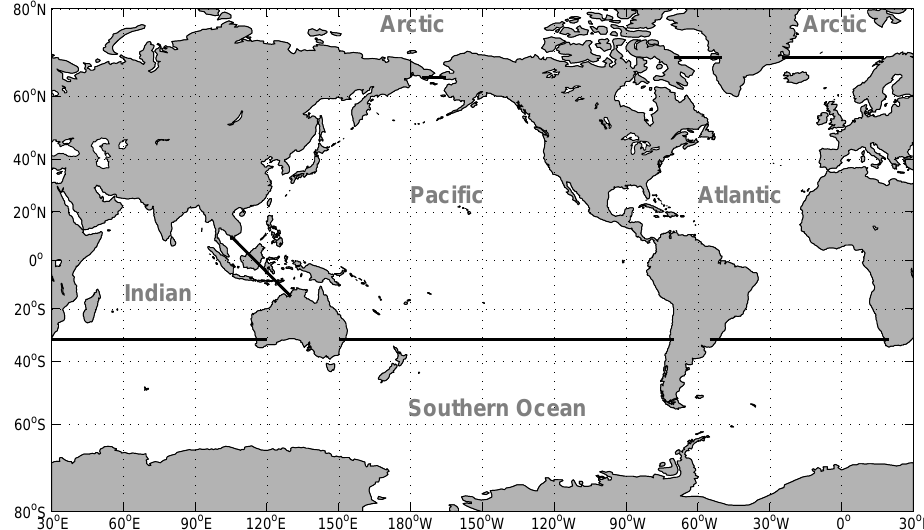
Fig. 3. Domains of the different ocean basins used for calculating the heat and freshwater budgets shown in Table 1. In the Southern Ocean to division is at 32S. In the North Atlantic the separation with the Arctic Basin is at approximately 70N, but following the ORCA model grid.